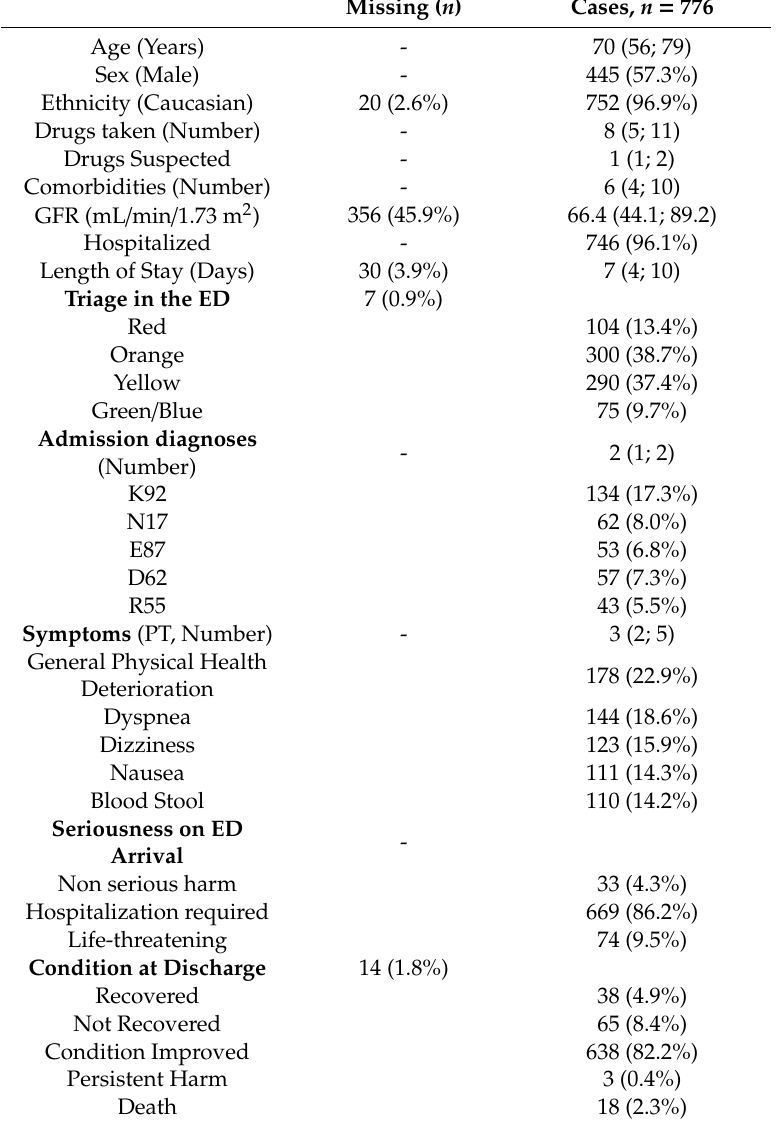
Table 1. Characteristics of the study population. Continuous variables are presented as median (interquartile range). Categorical variables are presented in absolute numbers